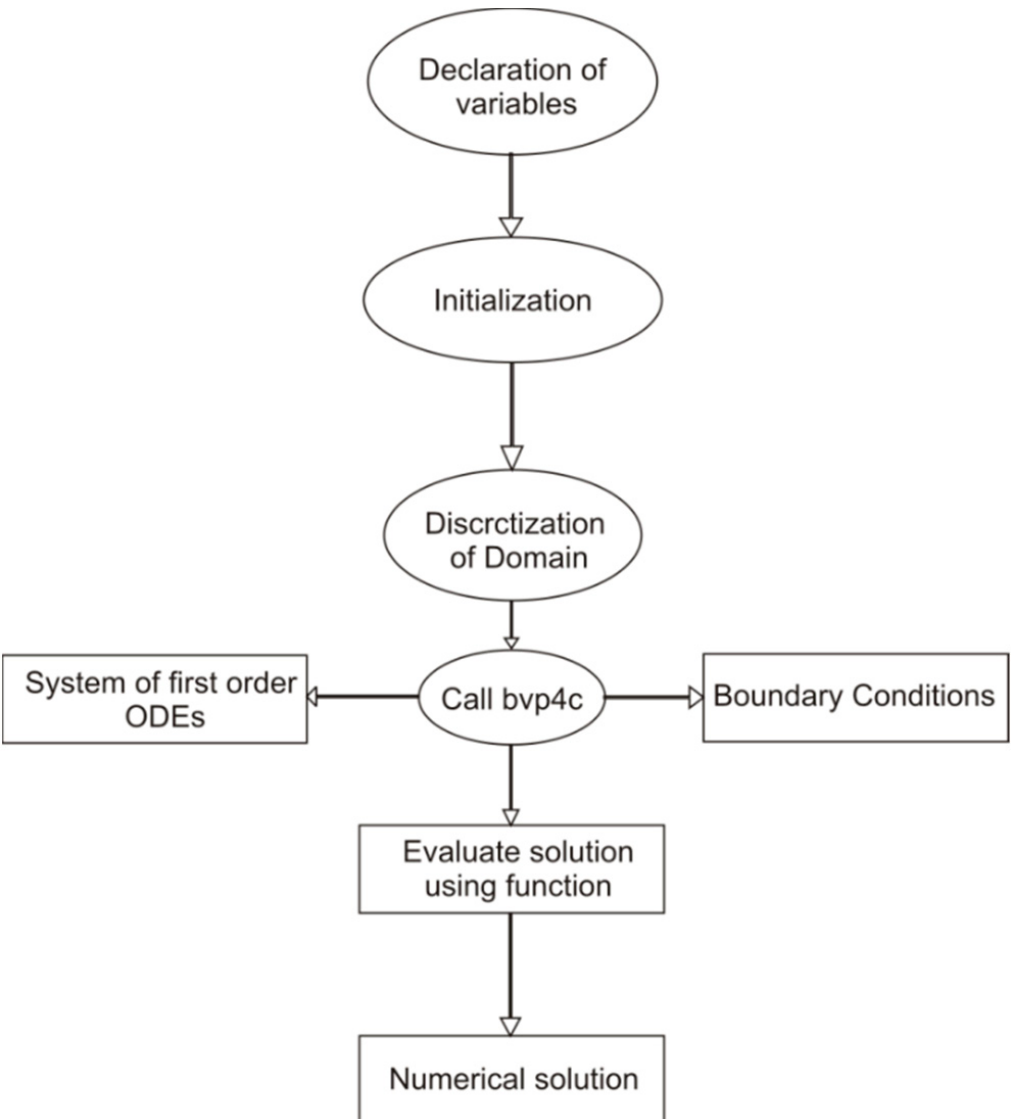
Figure 2. BVP4C computation flowchart.